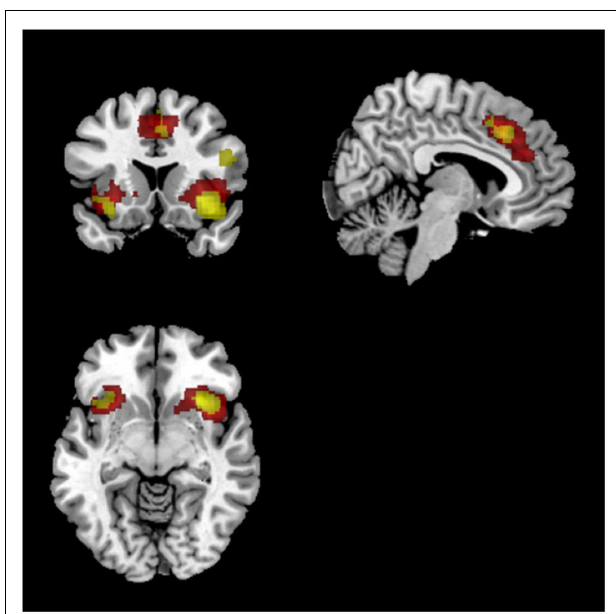
FIGURE 7 | Overlap between IC 65 (salience newtork) and SPM results . Red voxels show the spatial map for IC 65 which was identified to track task accuracy at both low ( < 0.1Hz) and high ( > 0.1Hz) frequencies. Activations in yellow were from the SPM analysis showing common activations between both groups for match compared to respond blocks. Both sets of activations were FDR corrected ( p <